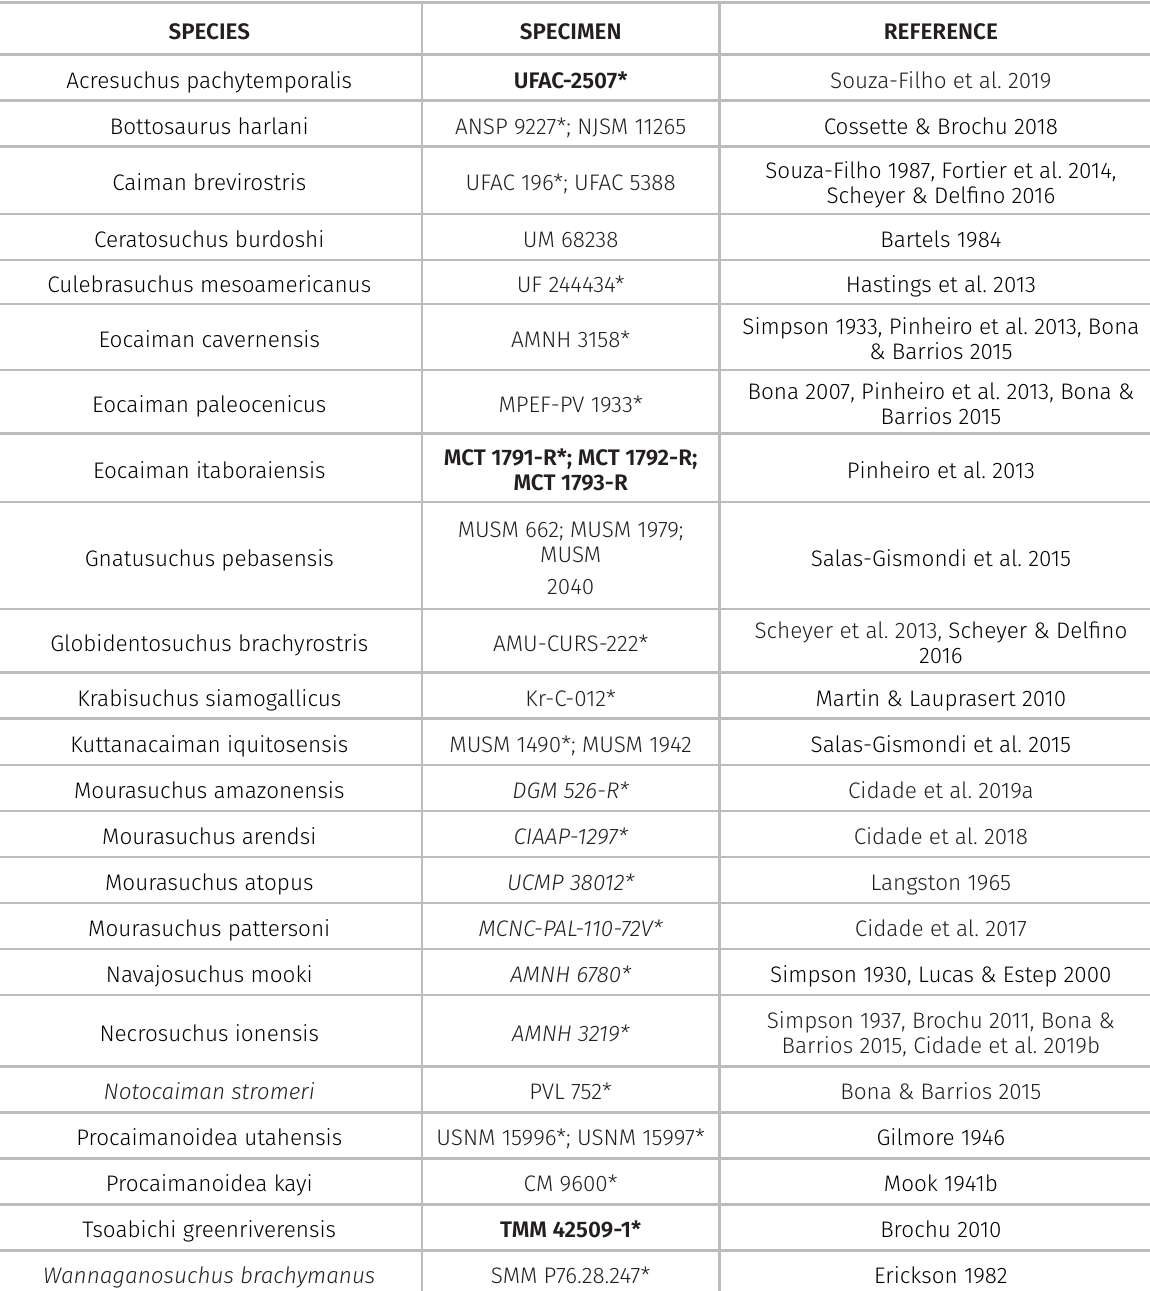
Table III. Studied fossil species and specimens. Legend: *, type specimen; bold, specimen personally studied; italic, donated photographs of the